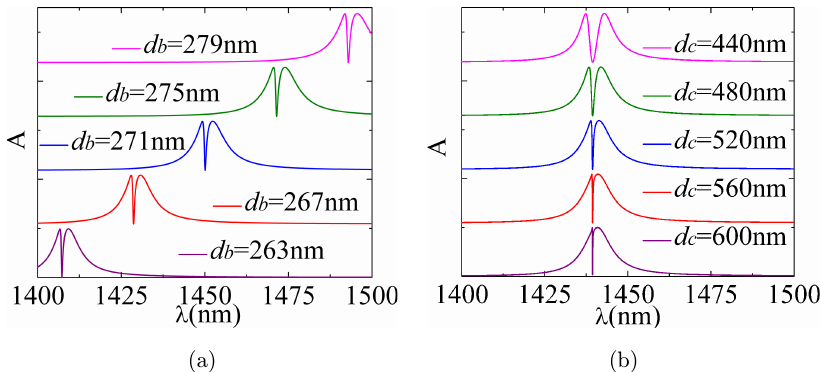
Fig. 3. The layer thickness-dependent absorption in the structure with N ¼ 2: (a) layer B and (b) layer C. The maximum absorptivity is 1 for all curves.